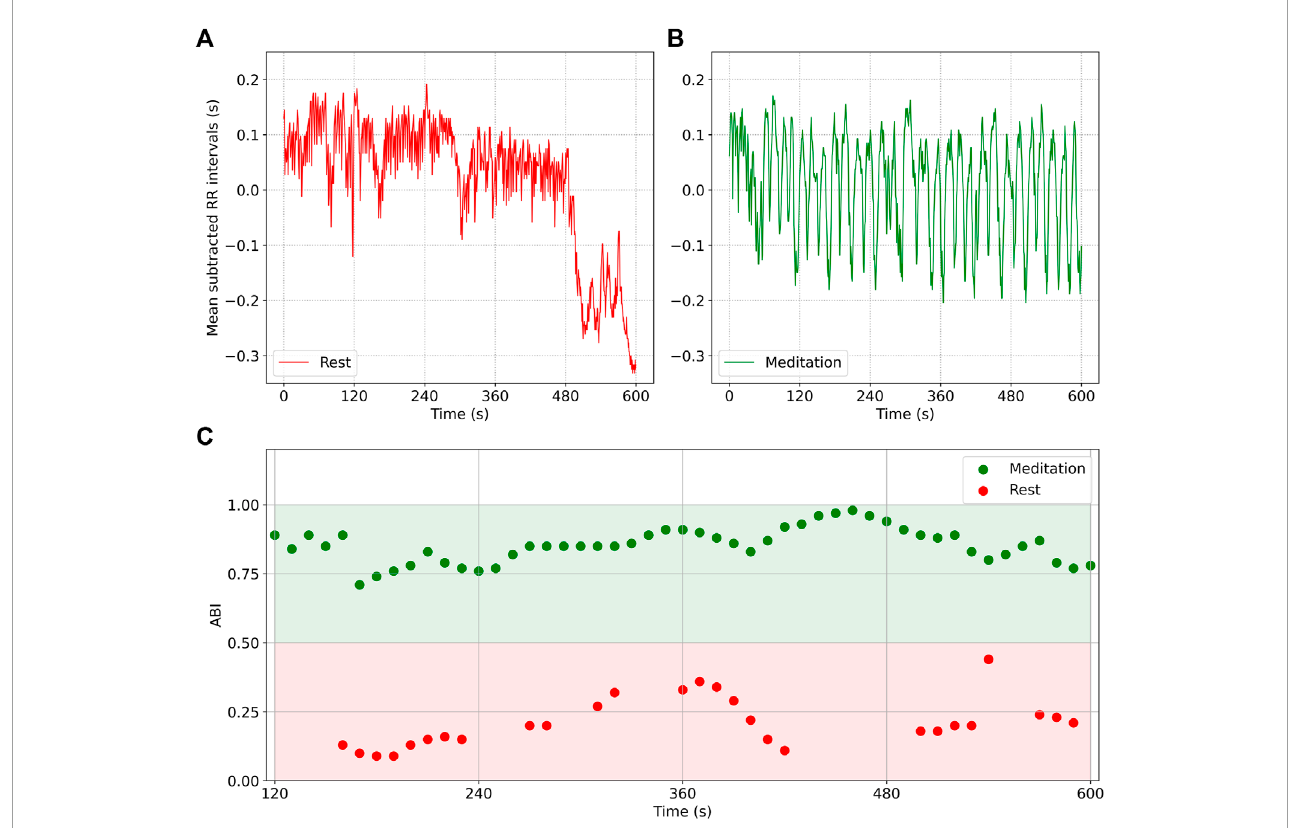
FIGURE 4 RR interval data (mean subtracted) from a participant at rest (A) and during Chi meditation (B) . RSA is noticeably present in both plots, but is dominant in (B) . Plot (C) shows the ABI computed from 2 min of data. The red data points are plotted for the waveform in (A) , while the green data points are plotted for the waveform in (B) . The ABI = .5 line is an approximate boundary that separates focused meditation from other